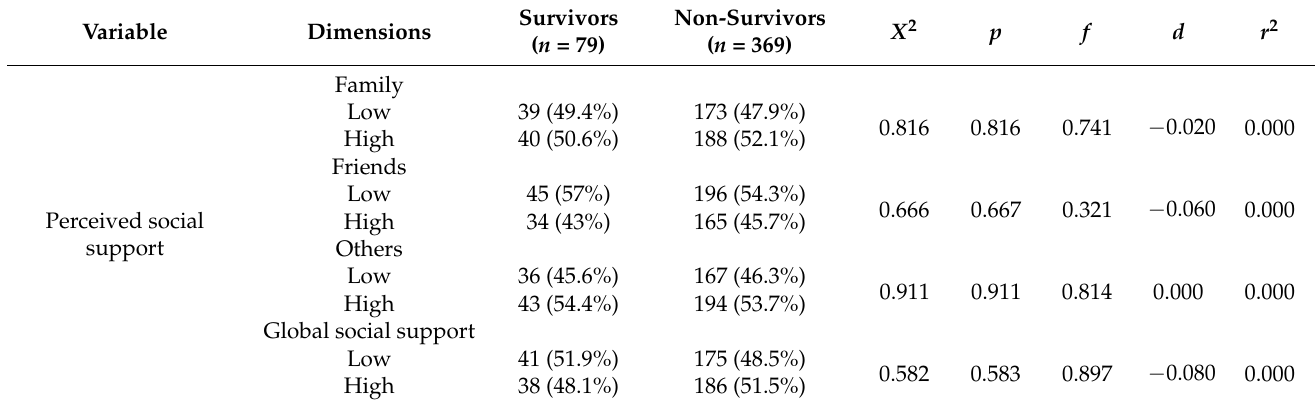
Table 5. Perceived social support of adolescents as a function of survivor